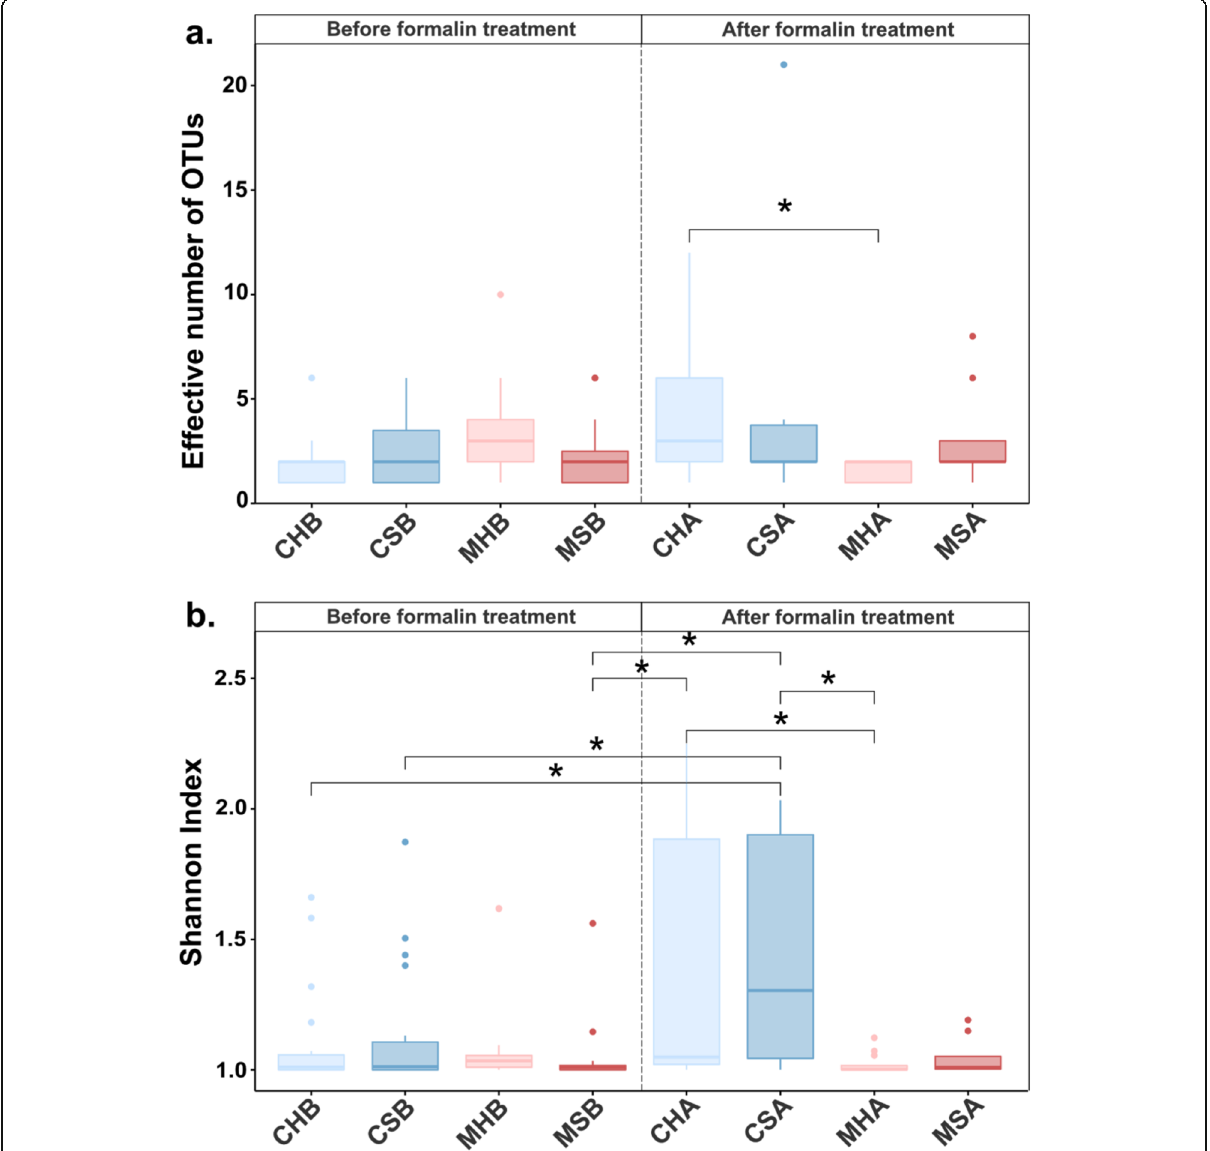
Fig. 2 Richness and Shannon index mean values and standard deviations for the eight groups. Boxplot showing the richness (effective number of OTUs) ( a ) and Shannon index ( b ) values for the eight groups. The group name abbreviations are defined in Fig. 1. Groups of samples before formalin treatment are on the left side of the plot, while those after treatment are on the right. Gut content samples are colored in blue while gut mucosa samples are shown in red. Color intensity discriminates between healthy (light) and sick (darker). All groups show low alpha diversities. Statistically significant pairwise differences (Wilcoxon rank-sum test, p < 0.05) in the mean richness and Shannon index values among the groups are highlighted with an asterisk